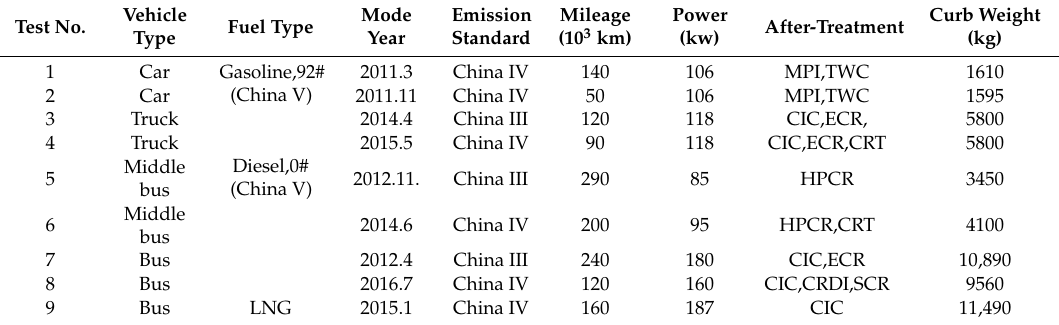
Table 1. Information on the on-road tested